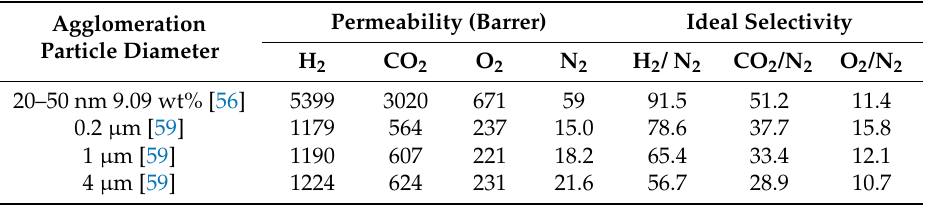
Table 6. The effect of agglomeration degree on the gas separation performance of the ZSM-5/C hybrid membranes. Permeability (Barrer) Ideal Selectivity Agglomeration Particle Diameter H